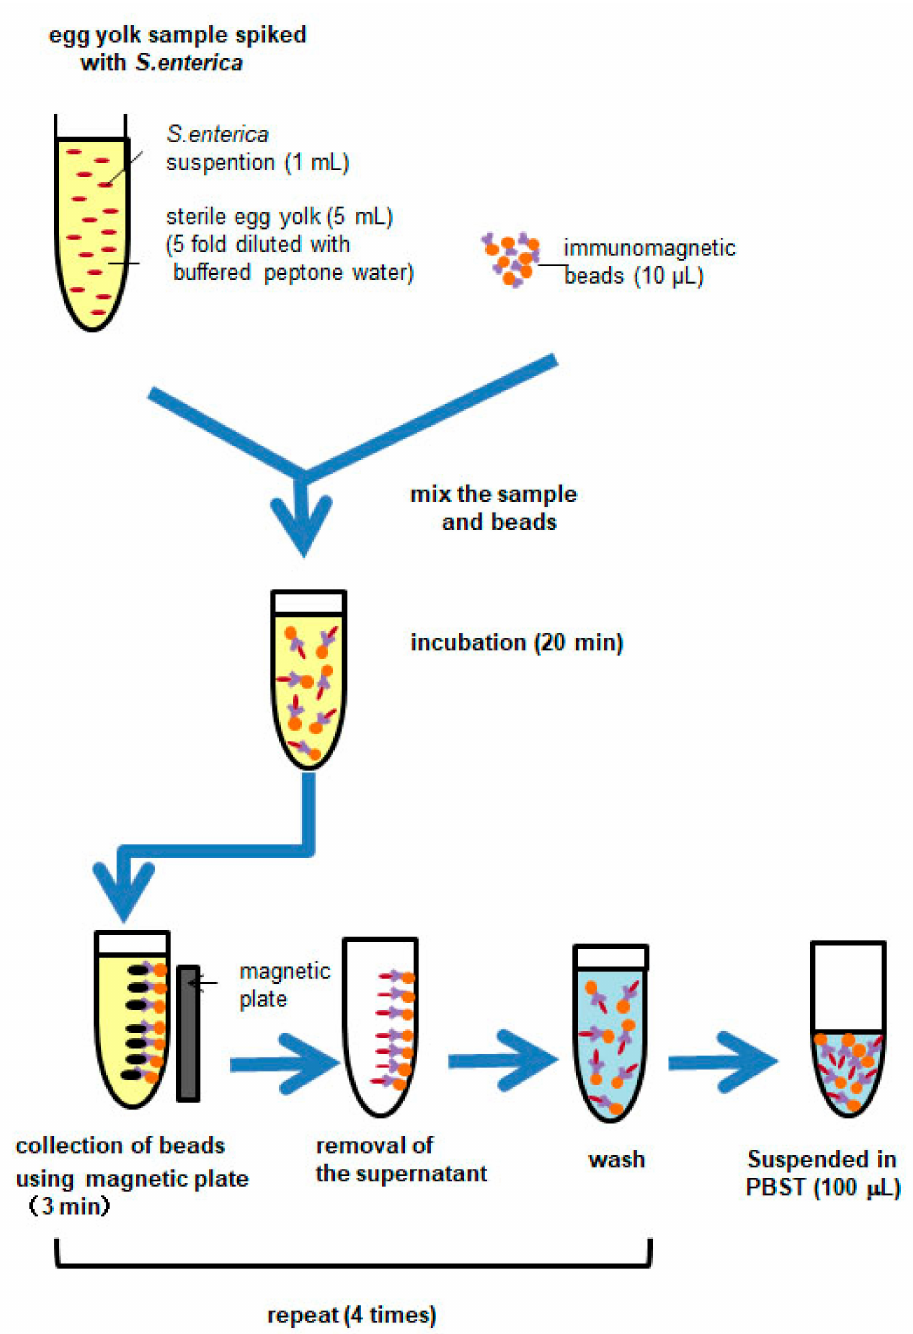
Figure 1. Sample preparation procedure from egg yolk sample spiked with Salmonella enterica using immunomagnetic beads: PBST (0.15 M NaCl, 0.01 M phosphate bu ff er, 0.05% Tween-20, pH